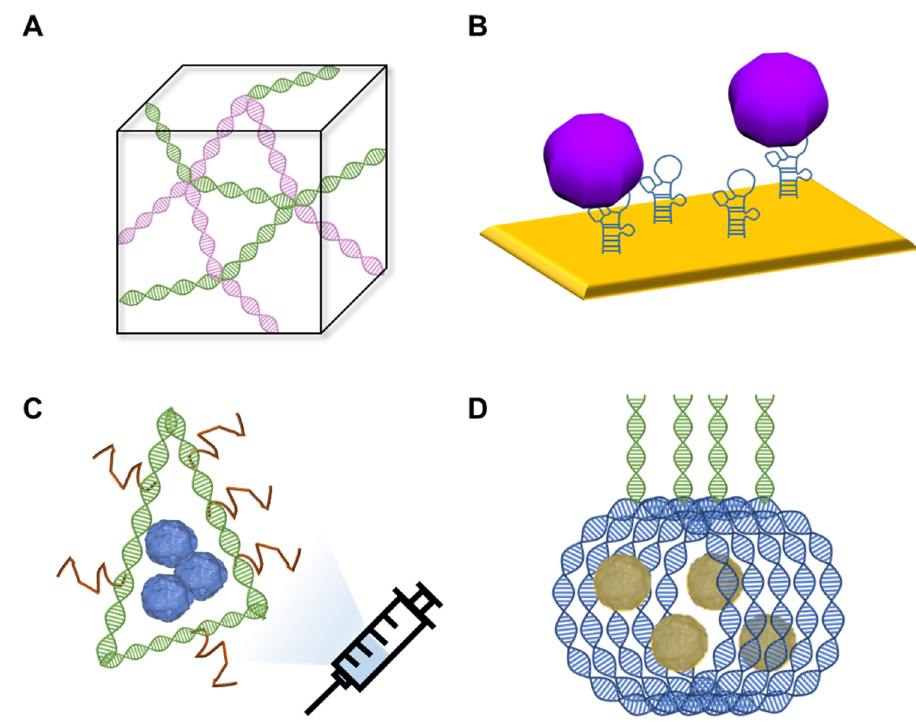
Figure 1. Application of DNA nanotechnology in ( A ) DNA hydrogel, ( B ) biosensors, ( C ) vaccines and ( D ) drug delivery.